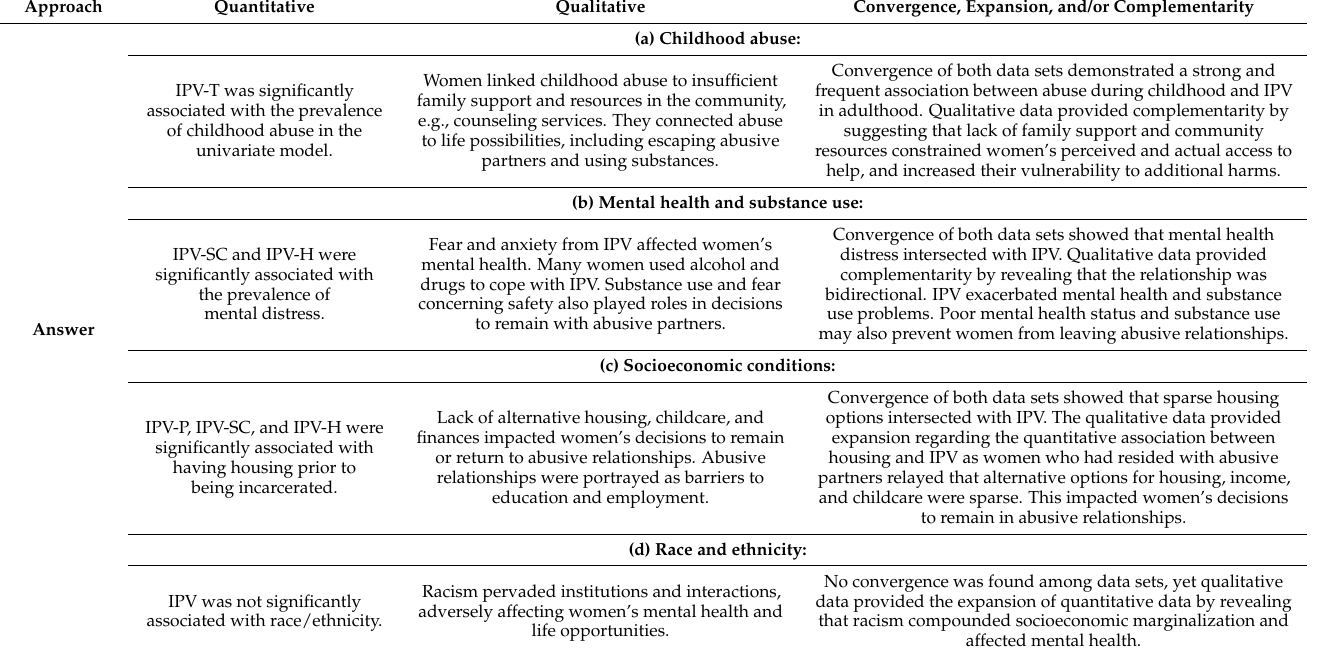
Table 5. Mixed-methods results of analysis of IPV and mental health and substance use, socioeconomic inequality, and racial/ethnic discrimination. Approach Quantitative Qualitative Convergence, Expansion, and/or